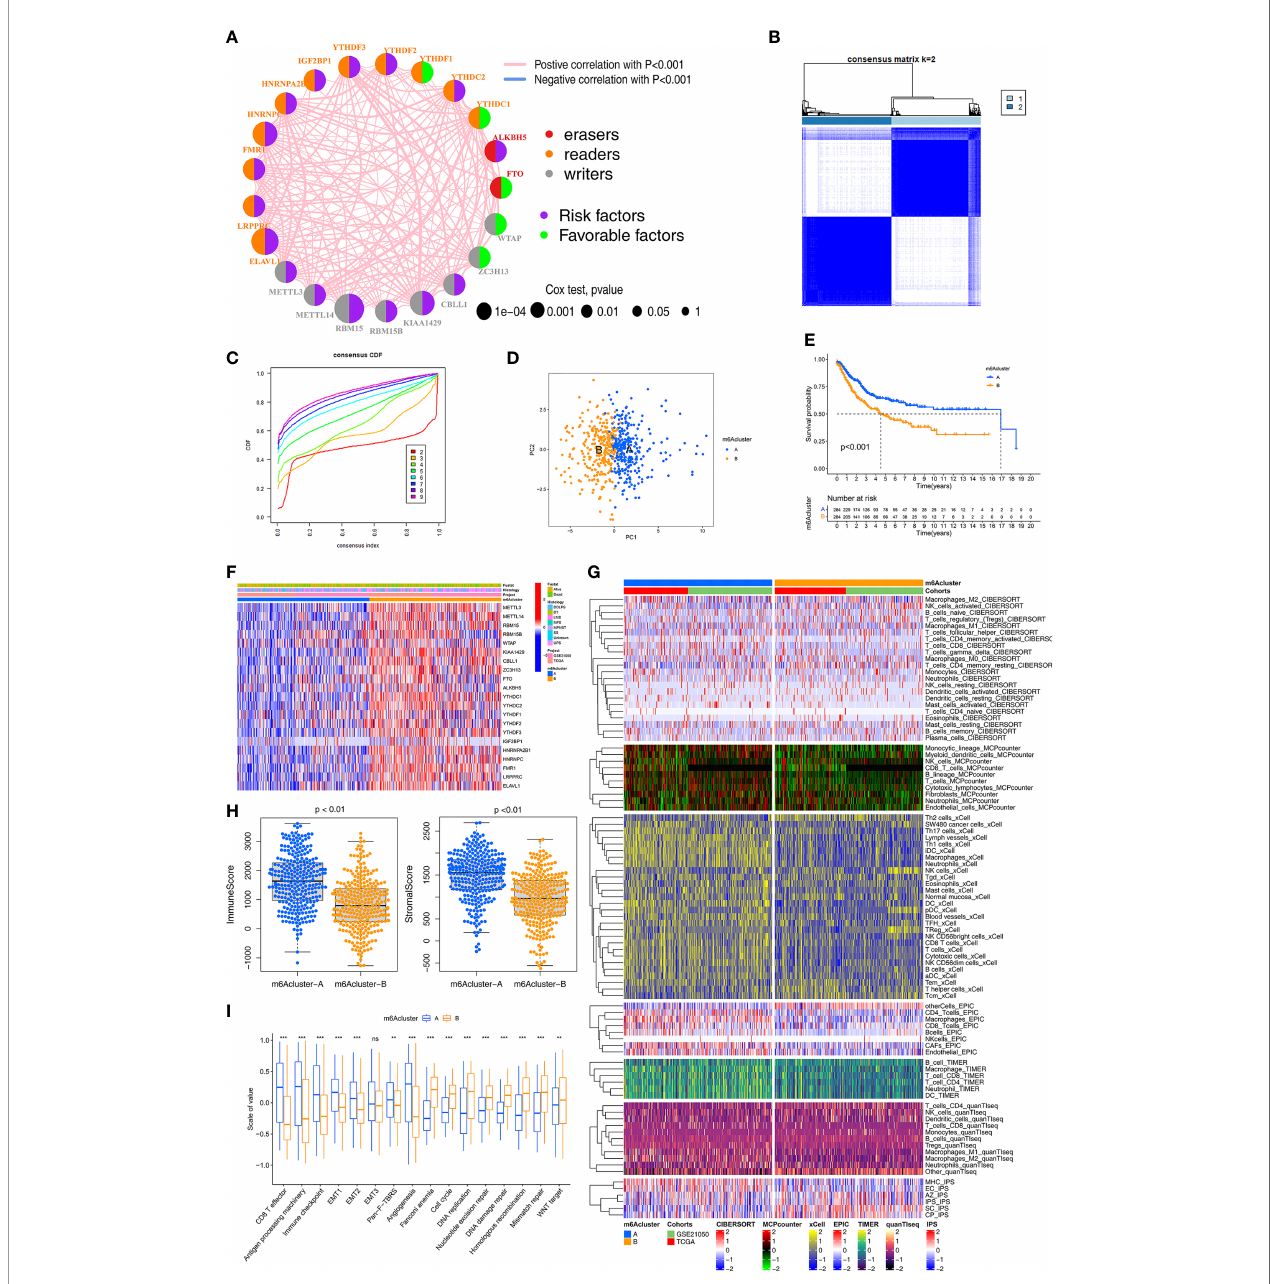
FIGURE 2 | Identi fi cation of m6A methylation modi fi cation patterns. (A) The interaction among m6A regulators in STS. The circle size represented the signi fi cance level of P values calculated by Log-rank test, p < 0.001, p < 0.01, p < 0.05 and P < 1, respectively. Favorable factors for overall survival are indicated in green, and risk factors indicated in purple. The lines connecting represent m6A regulators interactions estimated by Spearman correlation analysis. Positive correlation is indicated in pink and negative correlation in blue. (B) The clustering heatmap corresponding to the consensus matrix for k=2 obtained by consensus clustering. (C) Relative change in area under consensus CDF curve for k=2 to 9. (D) Principal component analysis for the transcriptome pro fi les of two m6A modi fi cation subtypes, showing a remarkable difference between different modi fi cation patterns. (E) Survival analyses for the two m6A modi fi cation patterns based on TCGA- SARC and GSE21050 STS cohort including 284 cases in m6Acluster-A, 284 cases in m6Acluster-B. Kaplan-Meier curves with Log-rank p value <0.001 showed a signi fi cant survival difference between two m6A modi fi cation patterns. (F) The expression of 21 m6A regulators between the m6Acluster-A and m6Acluster-B groups and corresponded clinical information also displays in heatmap. (G) Heatmap for immune responses based on CIBERSORT, MCPcounter, xCell, EPIC, TIMER, q uanTIseq and iPS algorithms between two m6Aclusters. (H) The Immune score and Stromal score from ESTIMATE algorithms of two m6Aclusters were analyzed and plotted. (I) The enrichment differences of immune signatures and typical biological processes between the m6Acluster-A and m6Acluster-B groups. The statistical difference was compared through the Kruskal – Wallis test. *P < 0.05; **P < 0.01; ***P < 0.001. ns, no signi fi